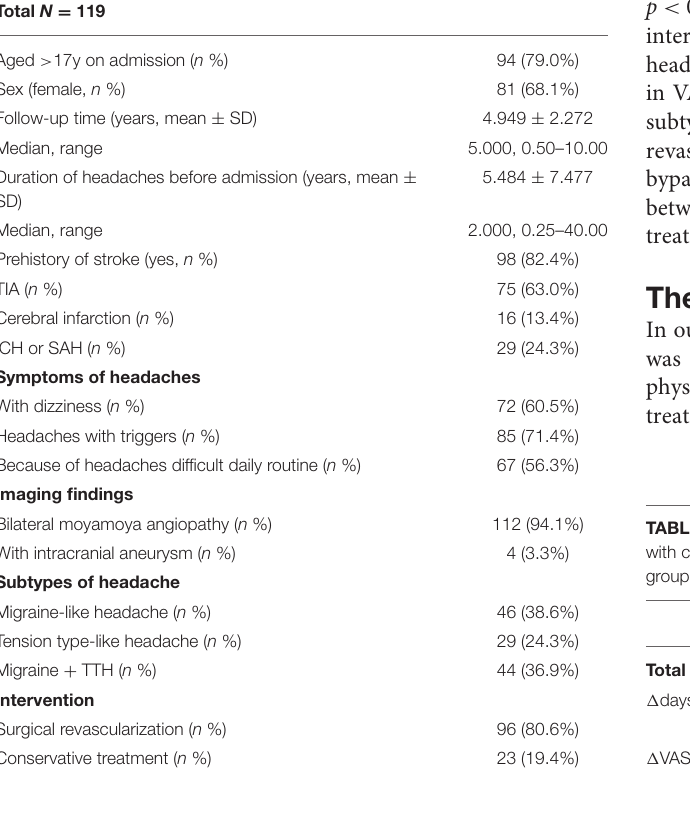
TABLE 1 | Baseline profiles of all patients in a large cohort of Chinese patients with HAMD.